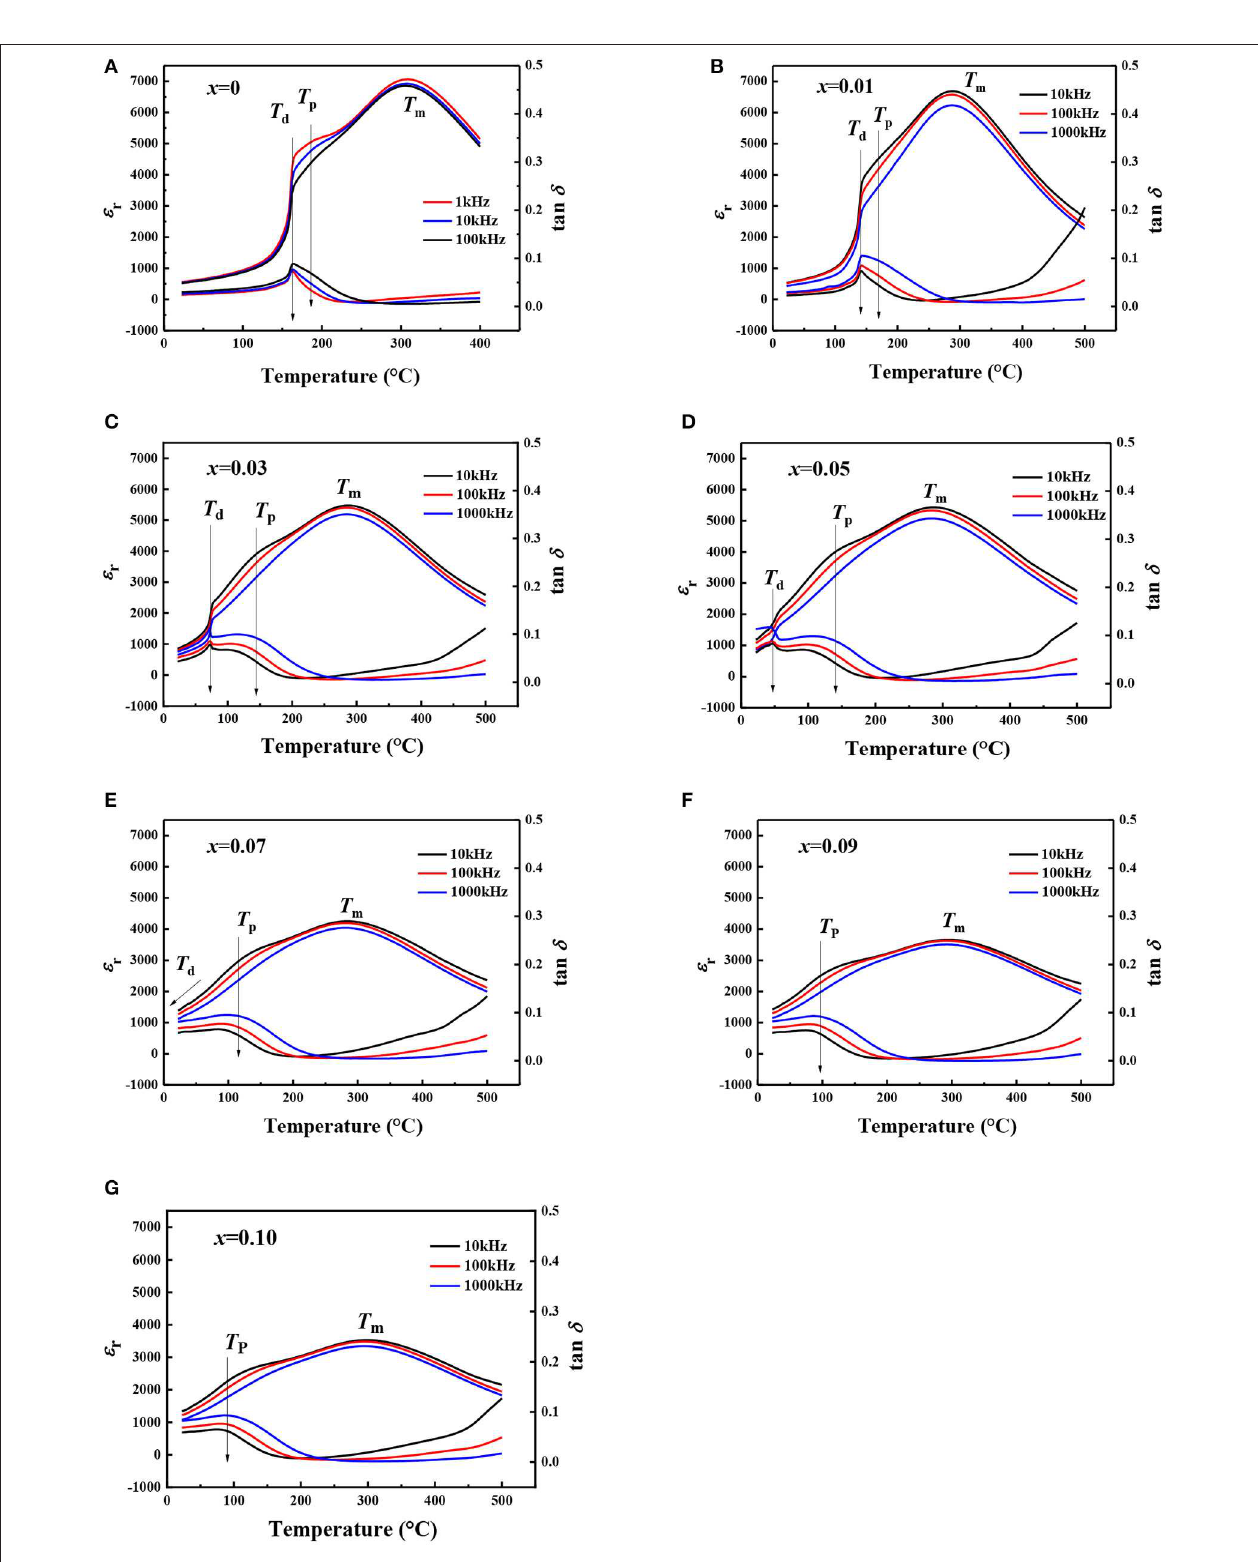
FIGURE 7 | Temperature-dependent dielectric spectra of polarized BNKT- x FSN ceramics with different FSN contents: (A) 0, (B) 0.01, (C) 0.03, (D) 0.05, (E) 0.07, (F) 0.09, (G) 0.10.